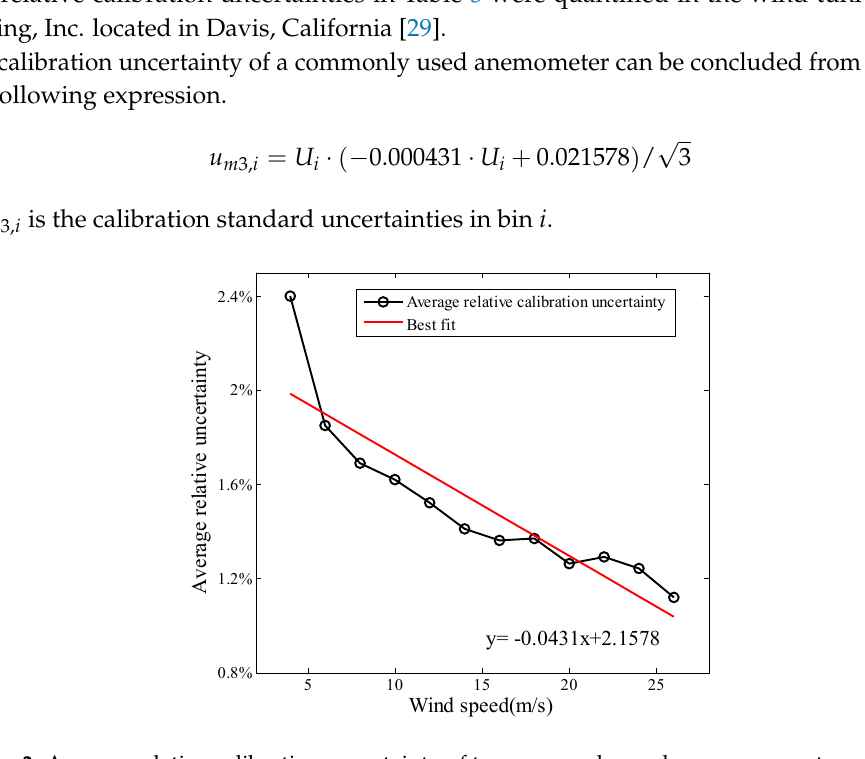
Figure 3. Average relative calibration uncertainty of ten commonly used cup anemometers with best linear regression fit.